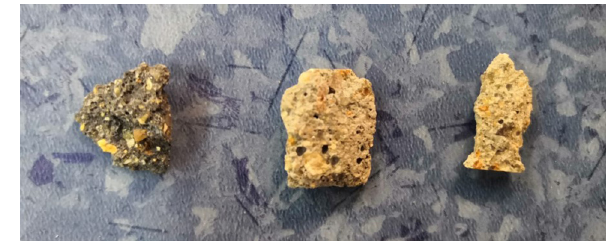
Figure 3: SEM micro - samples.